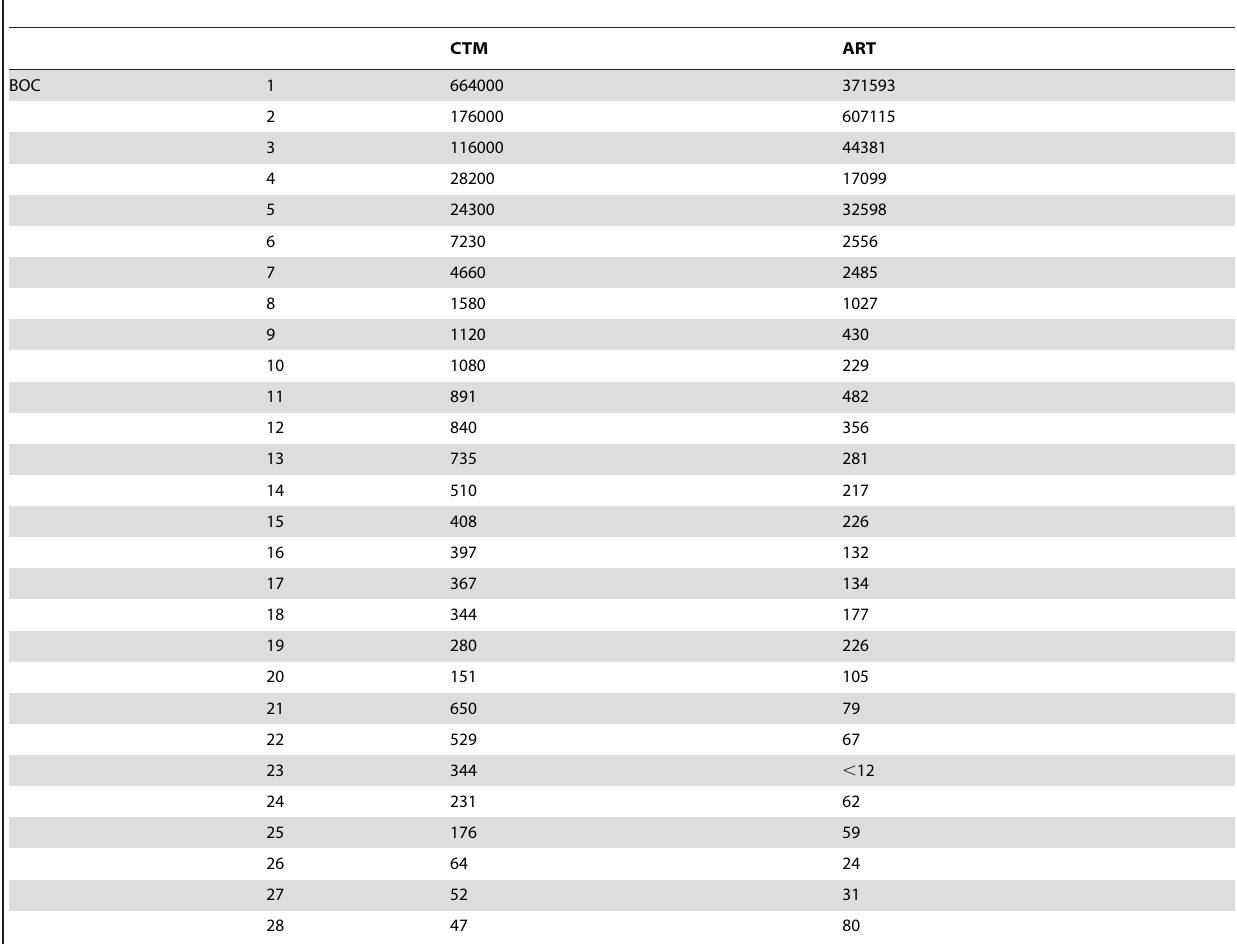
Table 4. HCV RNA levels according to ART and CTM measured in samples obtained 8 weeks after BOC treatment that yielded levels of $ 50 IU/ml in at least one of the two